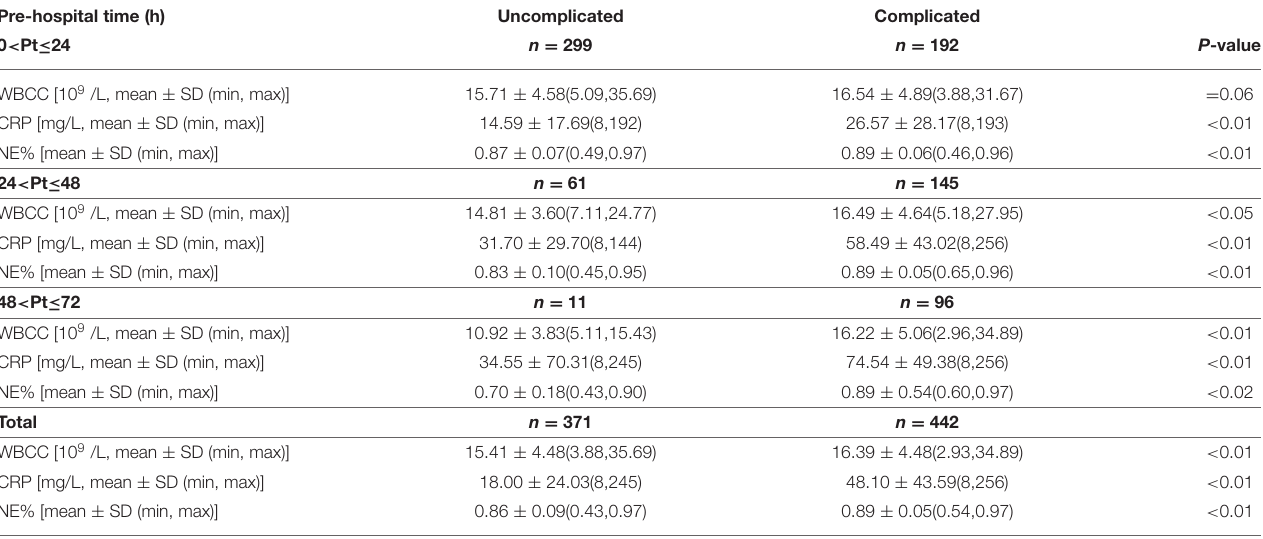
TABLE 5 | Pre-hospital time was divided into three groups. Pre-hospital time (h) Uncomplicated Complicated